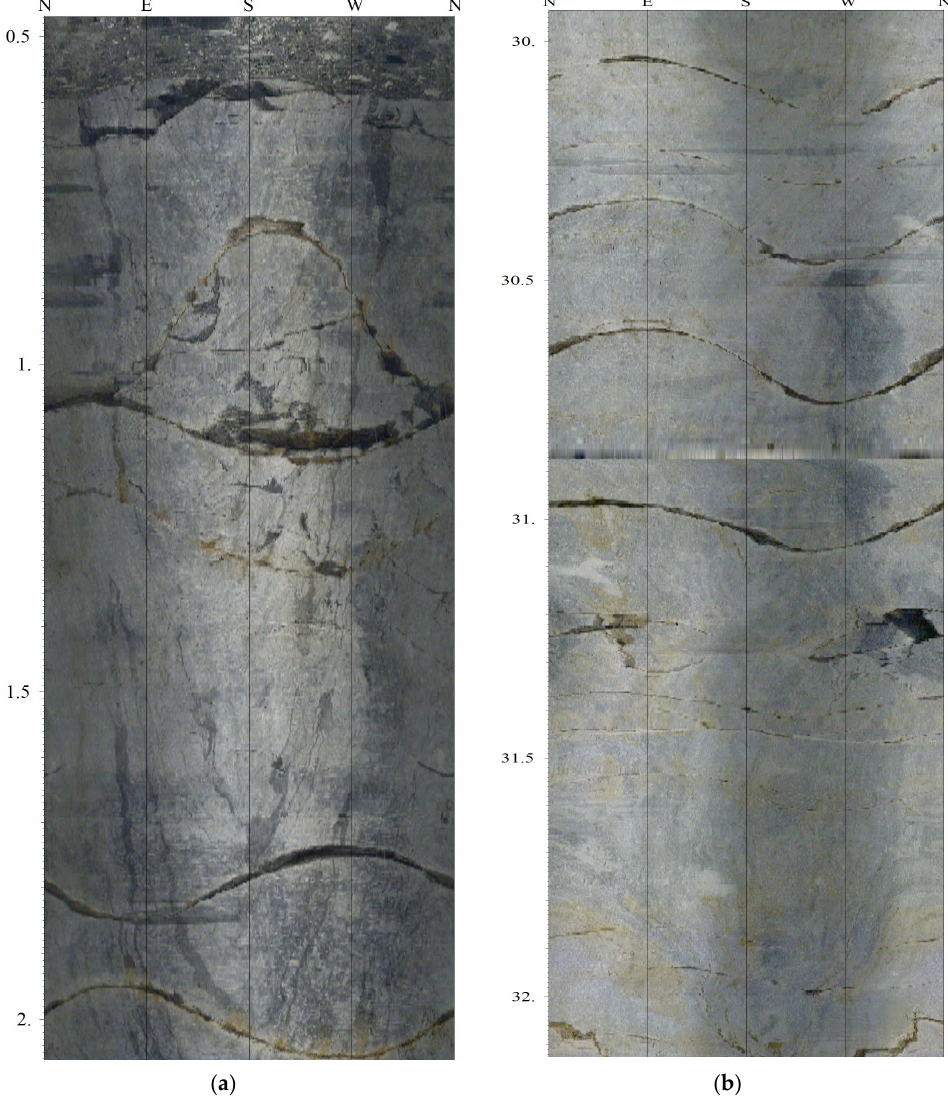
Figure 3. Sections of the measured panoramic borehole images. ( a ) Section of the panoramic borehole image taken at a depth of about 0.3~2.3 m in hole number DJ1; ( b ) Section of the panoramic borehole image taken at a depth of about 30~32 m in hole number